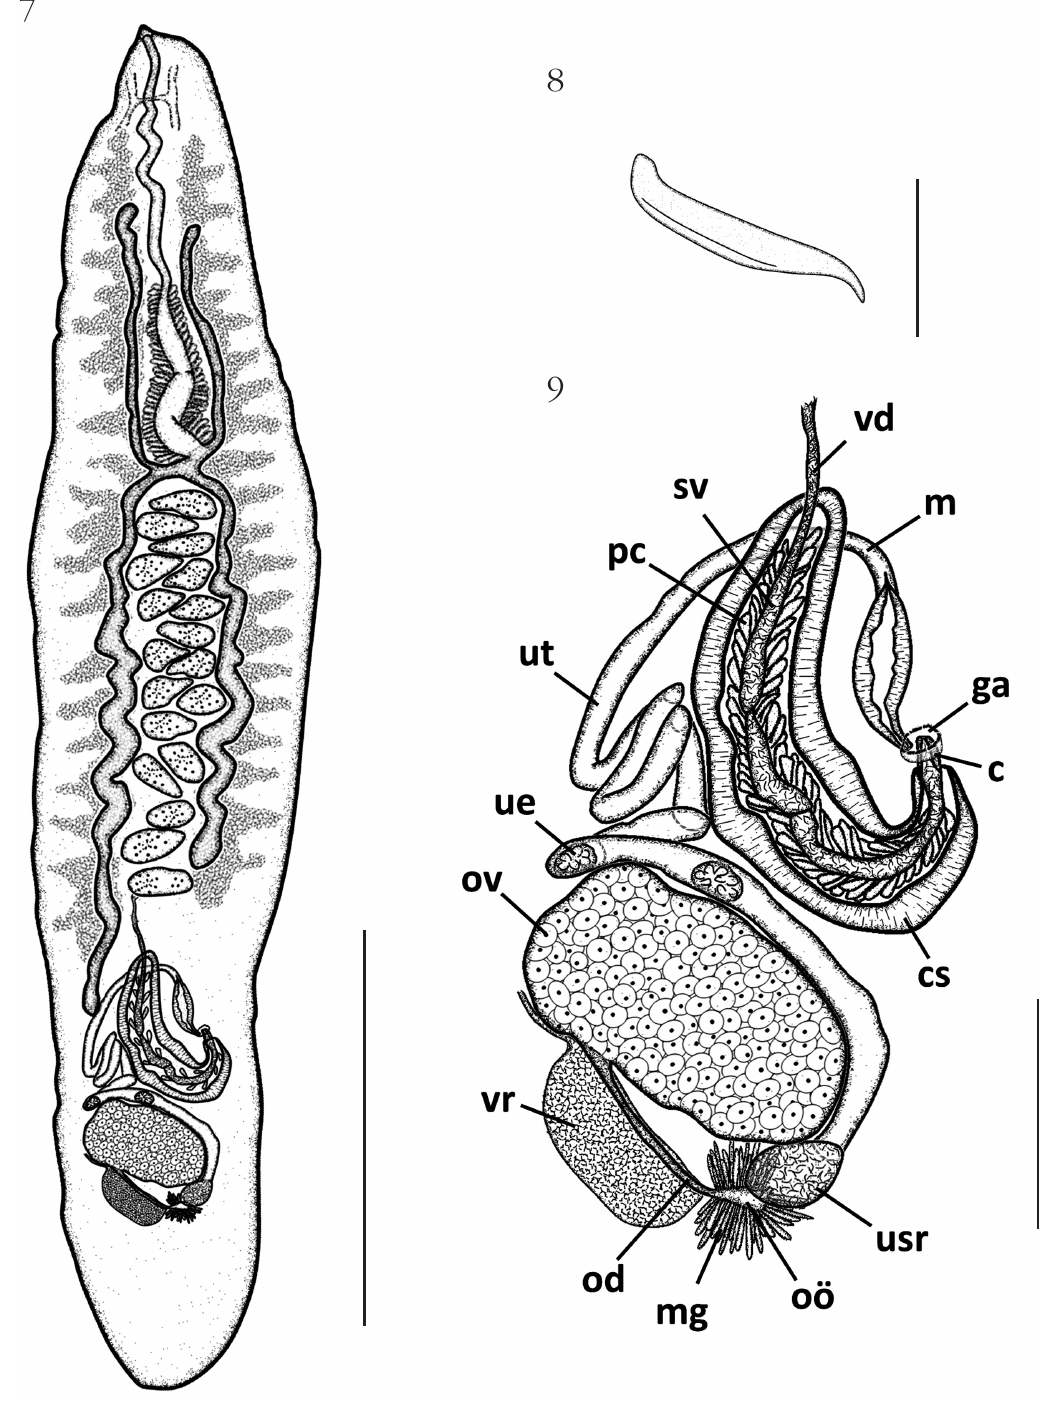
Scale bars: Fig. 7: 500 μ m; Fig. 8: 10 μ m; Fig. 9: 100 μ m. Abbreviations: vd, vas deferens; sv, seminal vesicle; m, metraterm; pc, prostatic cells; ut, uterus; ga, genital atrium; c, cirrus; ue, uterine egg; ov, ovary; cs, cirrus sac; vr, vitelline reservoir; usr, uterine seminal receptacle; od, oviduct; oö, oötype; mg, Mehlis’